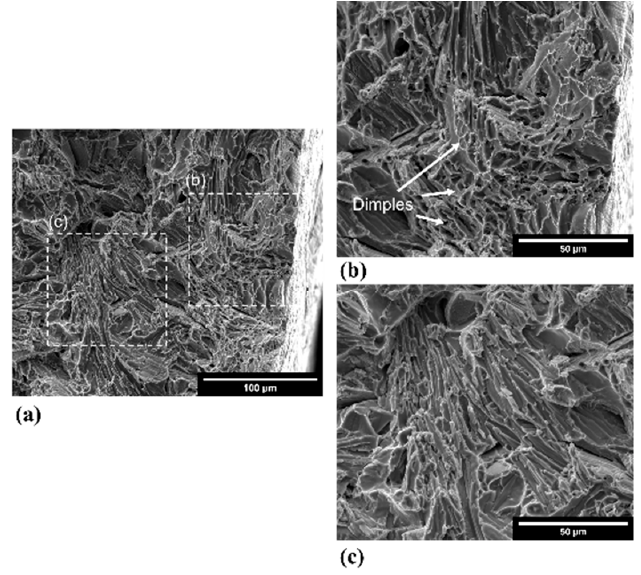
Figure 8. ( a ) SE ‐ SEM image showing representative tensile fracture surface of a longitudinal tensile fracture sample, highlighting the typical fracture features observed. Higher magnification regions highlighted from enclosed areas in ( a ) show signs of ( b ) dimpled morphology and ( c ) a less ‐ ductile, more ‐ cleaved region.